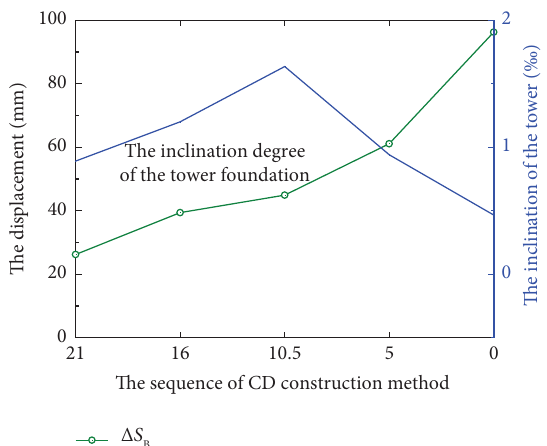
Figure 12: Te max vertical displacement and the inclination of tower under the sequence of CD construction method.